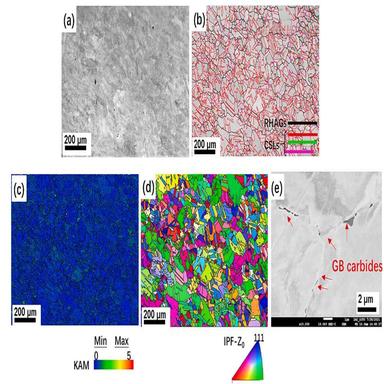
EBSD and BSE analysis of the Alloy 690, showing (a)original surface, (b) the GB types, (c) KAM, (d) grain size, and (e) GB carbides.